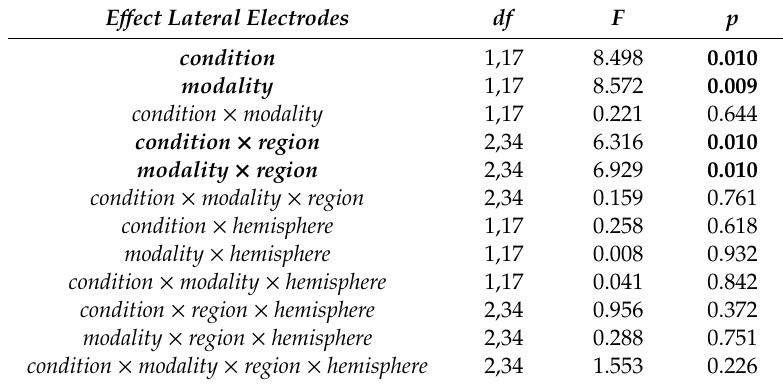
Table 1. Statistical results of the ANOVA condition × modality × region × hemisphere for event-related brain potentials (ERP) data on lateral electrodes. Data from the time window 500–900 ms was considered for spoken sentences, while data from the time window 800–1200 ms entered analyses for sung sentences. Significant e ff ects ( p < 0.050) are marked in